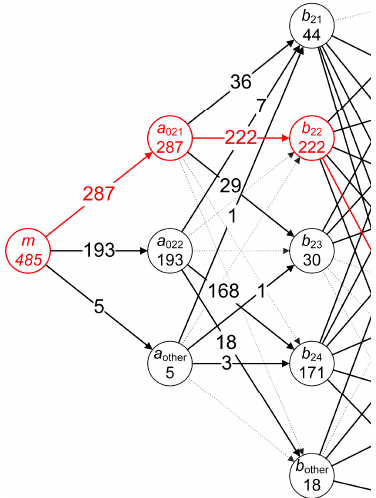
Figure 6. A fragment of the accident situation development model (own elaboration).